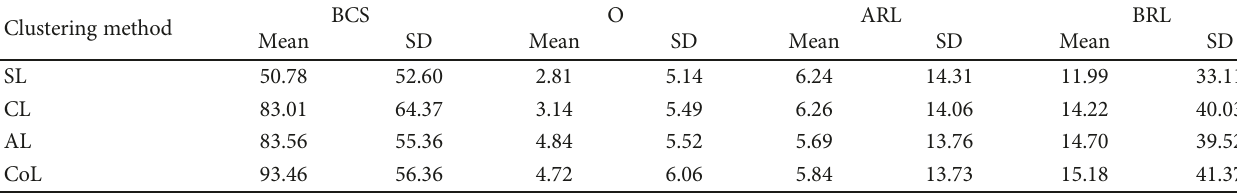
Table 6: Quality of rule clusters vs. clustering